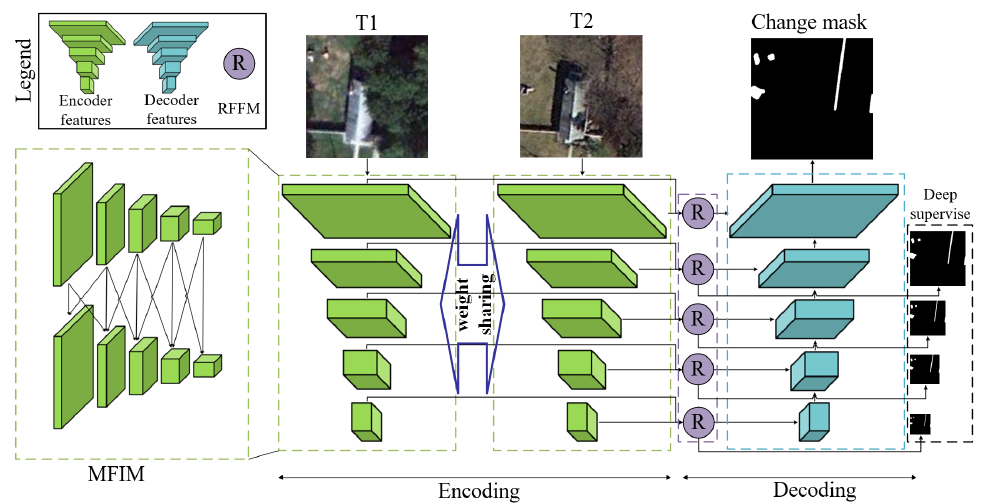
Figure 2. The overall structure of RFNet. MFIM indicates the multi-stage feature interaction module. RFFM denotes the region-based feature fusion module. The symbols T1 and T2 are the bitemporal